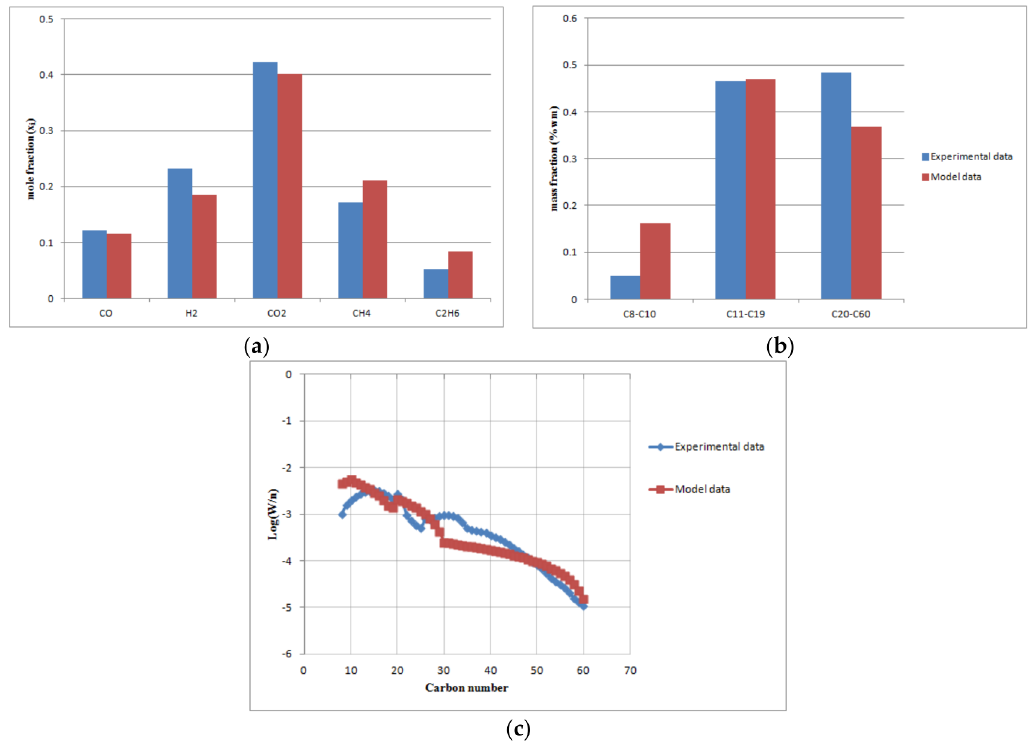
Figure 7. The comparison of the predicted model with experimental data at change load conditions (volumetric gas flow rate 7.5 m 3 /h, T = 503 K, ε cat = 0.34, P = 20 bar): ( a ) off-gas molar fractions; ( b ) FT products (naphtha, diesel, wax); ( c ) ASF